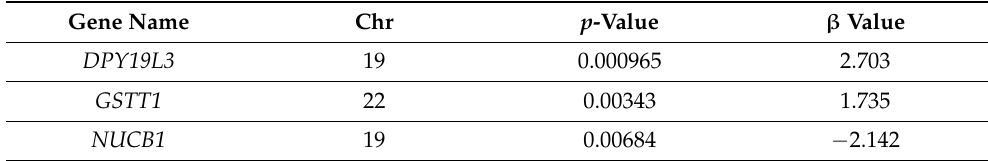
Table 4. Univariate logistic regression analysis of the association between gene expression and NDR/DR